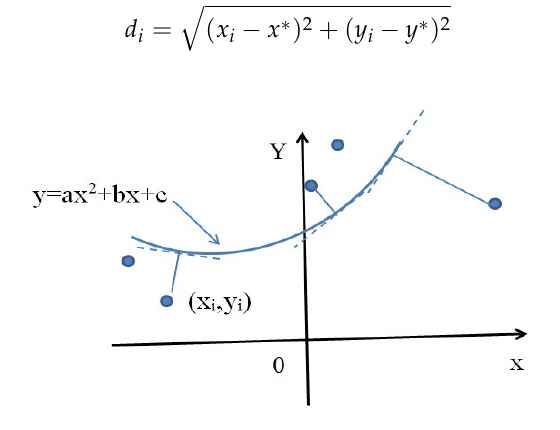
Figure 7. Curve line